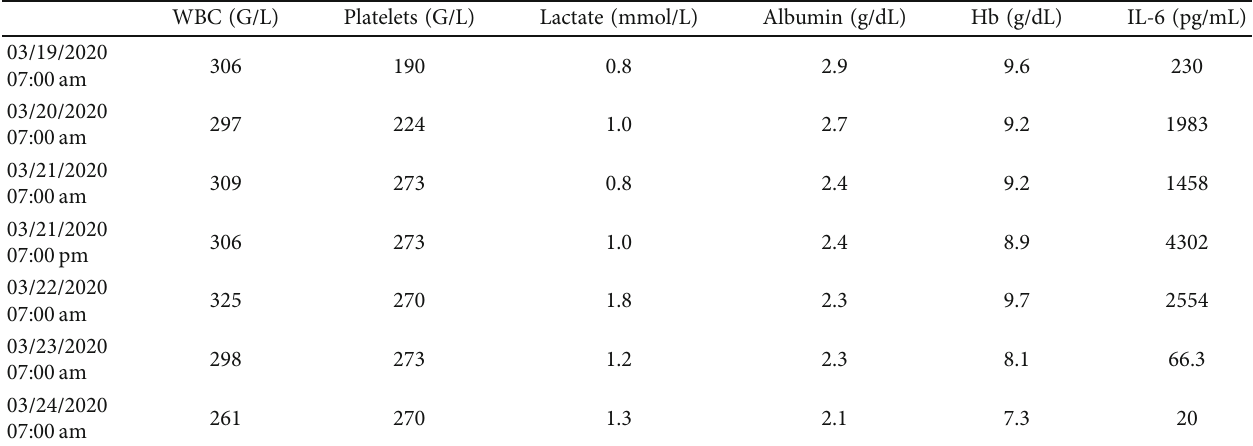
Table 1: Laboratory results pre-, during, and post-CytoSorb® treatment. Initiation of CytoSorb® therapy from 03/21/2021 (09:45pm) to 03/22/2021 (07:00